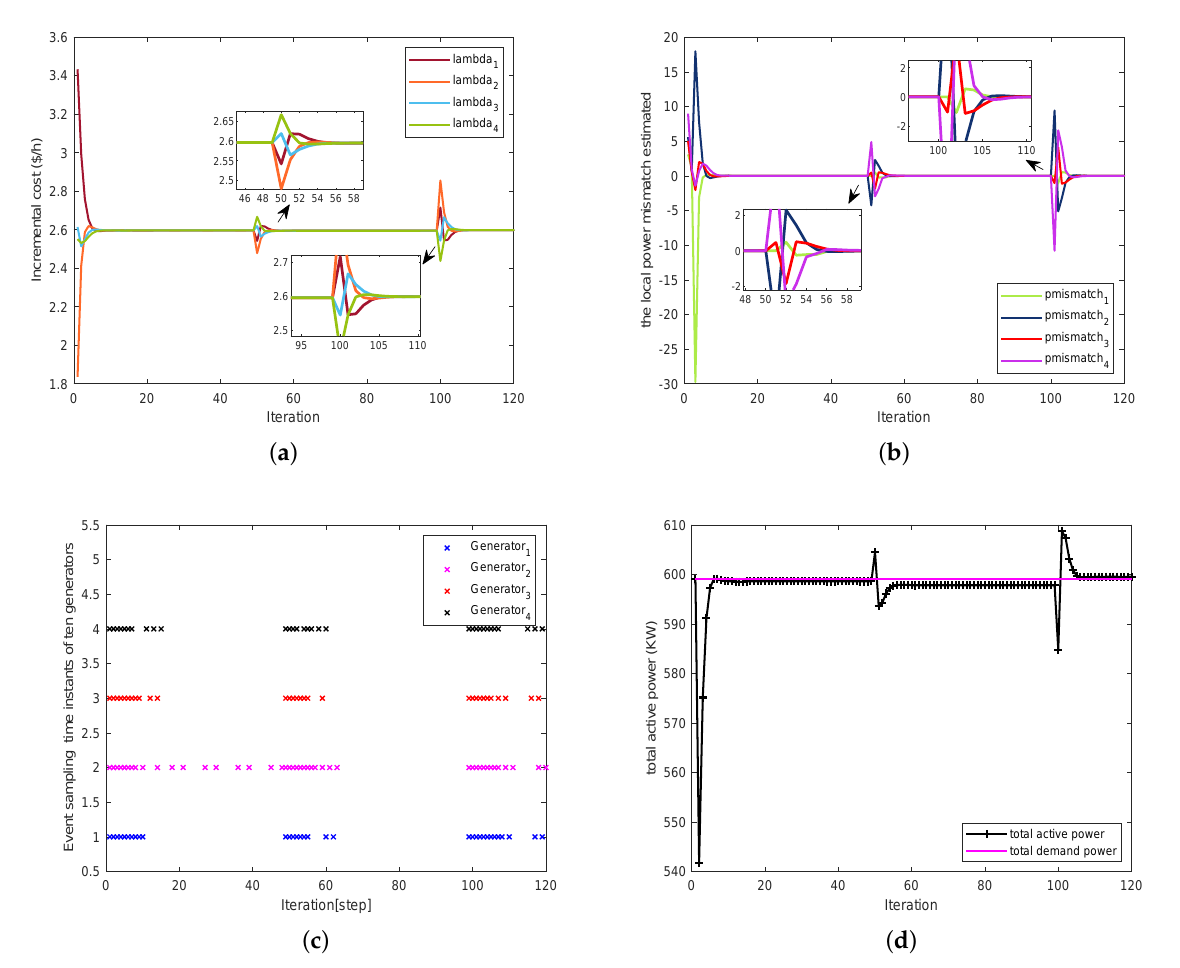
Figure 4. ( a ) The iteration of incremental cost λ i ( k ) . ( b ) The iterative process of auxiliary variable